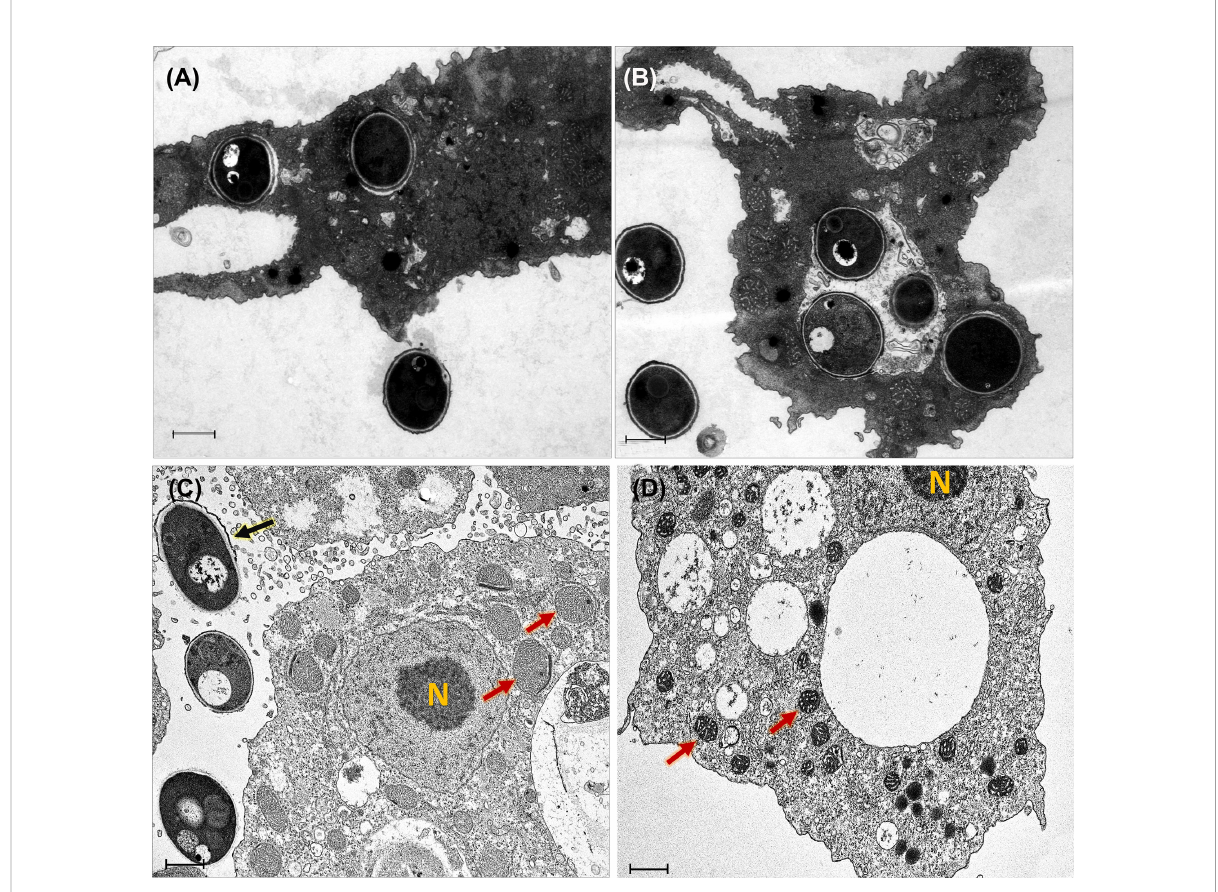
FIGURE 3 Transmission electron micrographs of T. marneffei interacting with A . castellanii trophozoites after co-cultivation at 37°C. The conidia of T. marneffei are phagocytosed and enclosed in a membrane bound vacuole of amoeba cell after 30 minutes (A) and 2 h (B) post-infection. T. marneffei yeast cell (depict by black arrow) interacted with amoeba manifest reduced cytoplasmic electron density and caused swelling of A . castellanii mitochondria (depicted by two red arrows) at 48 h post-infection, these phenomena indicated the amoeba cell injury (C) . The control A . castellanii trophozoites without T. marneffei infection, the two red arrows represented the normal appearance of mitochondria (D) . The photograph was taken under 3,000x magni fi cations with a JEM-2200FS electron microscope. N represents the A . castellanii nucleus and the scale bars represented 1 m